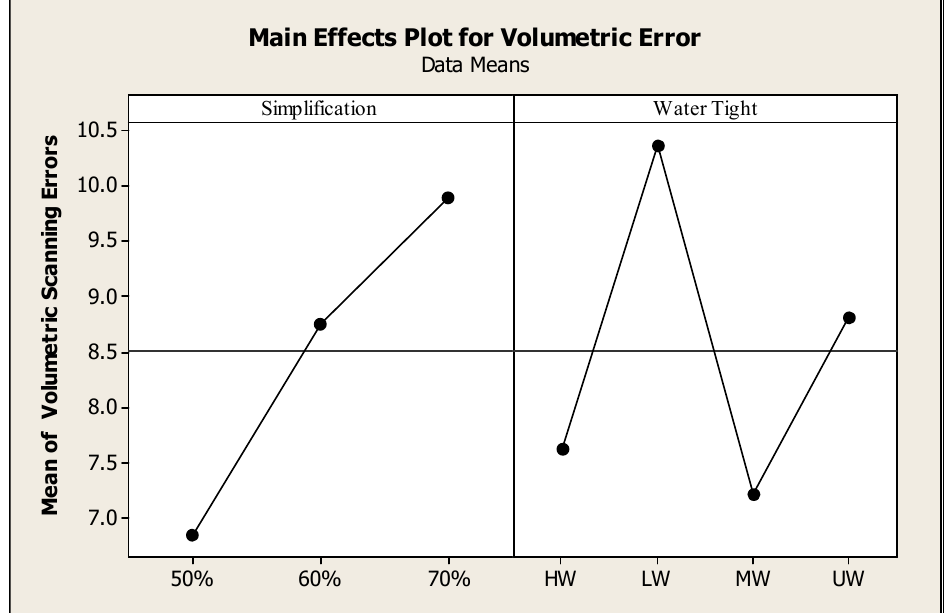
Figure 5. Main effects plot for volumetric error (Mode A).